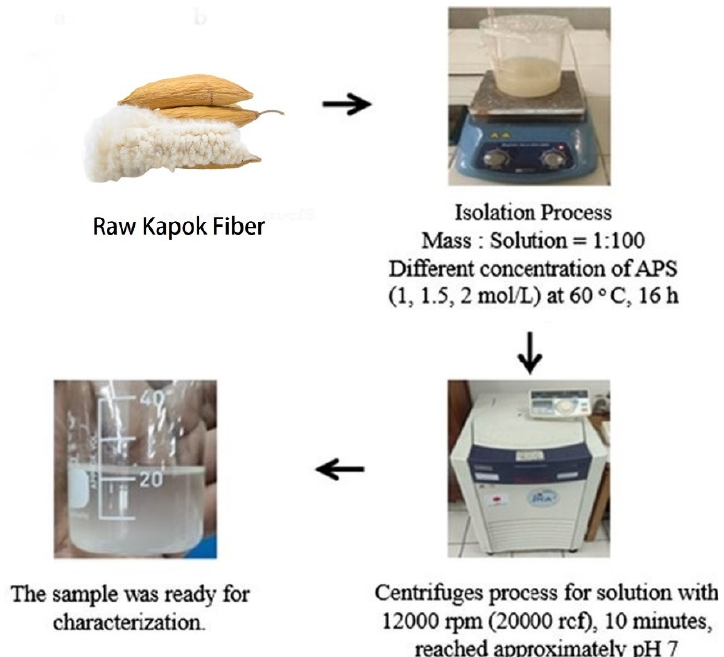
Figure 6. Isolation process of kapok fiber with the oxidation method. Reprinted with permission from Ref. [83]. Copyright 2021, copyright Springer Nature.